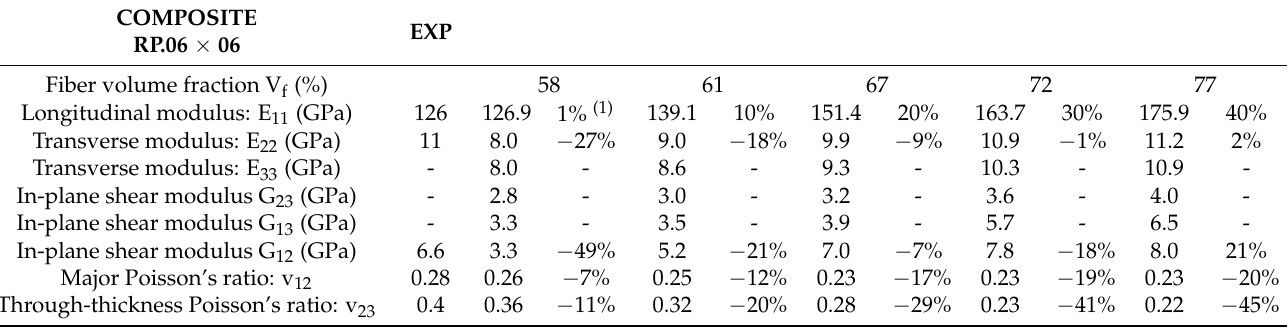
Table 8. Comparisons between the measured experimental (EXP) and the predicted effective properties for RANDOM PACKAGING ARRANGEMENT RP.06 × 06 with different fiber volume fraction ratios.